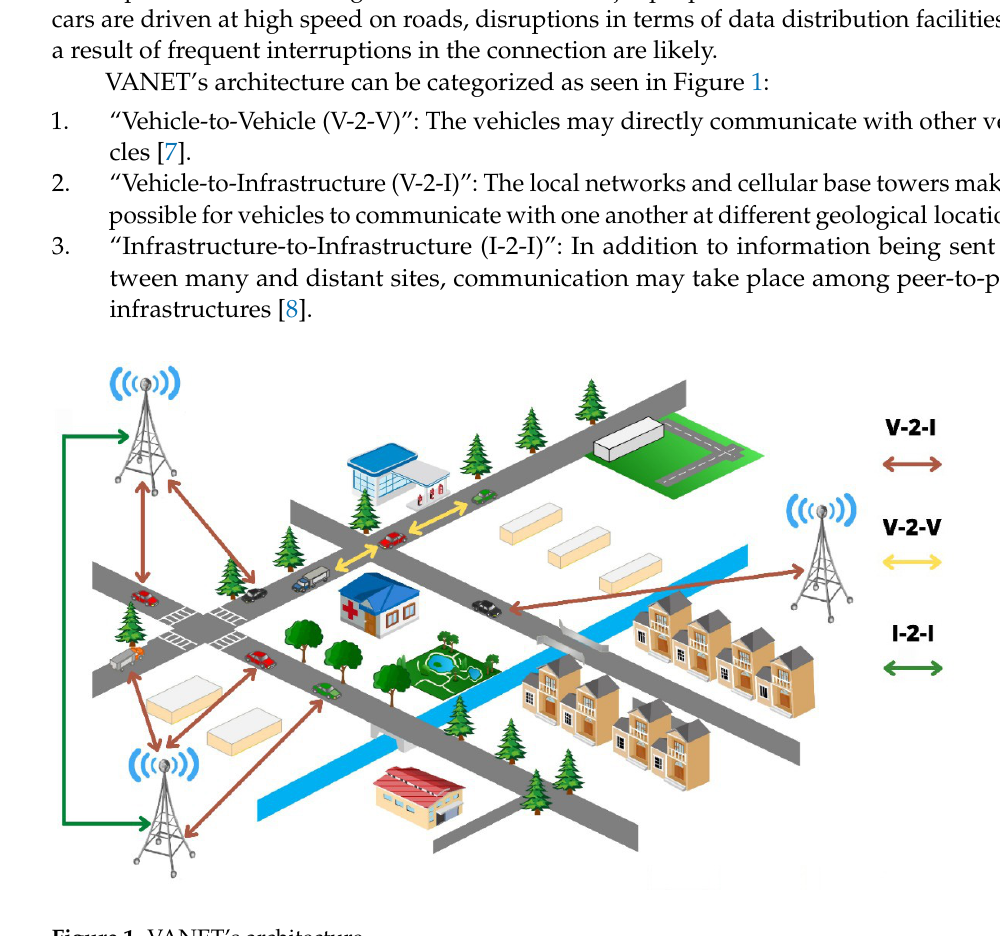
Figure 1. VANET’s